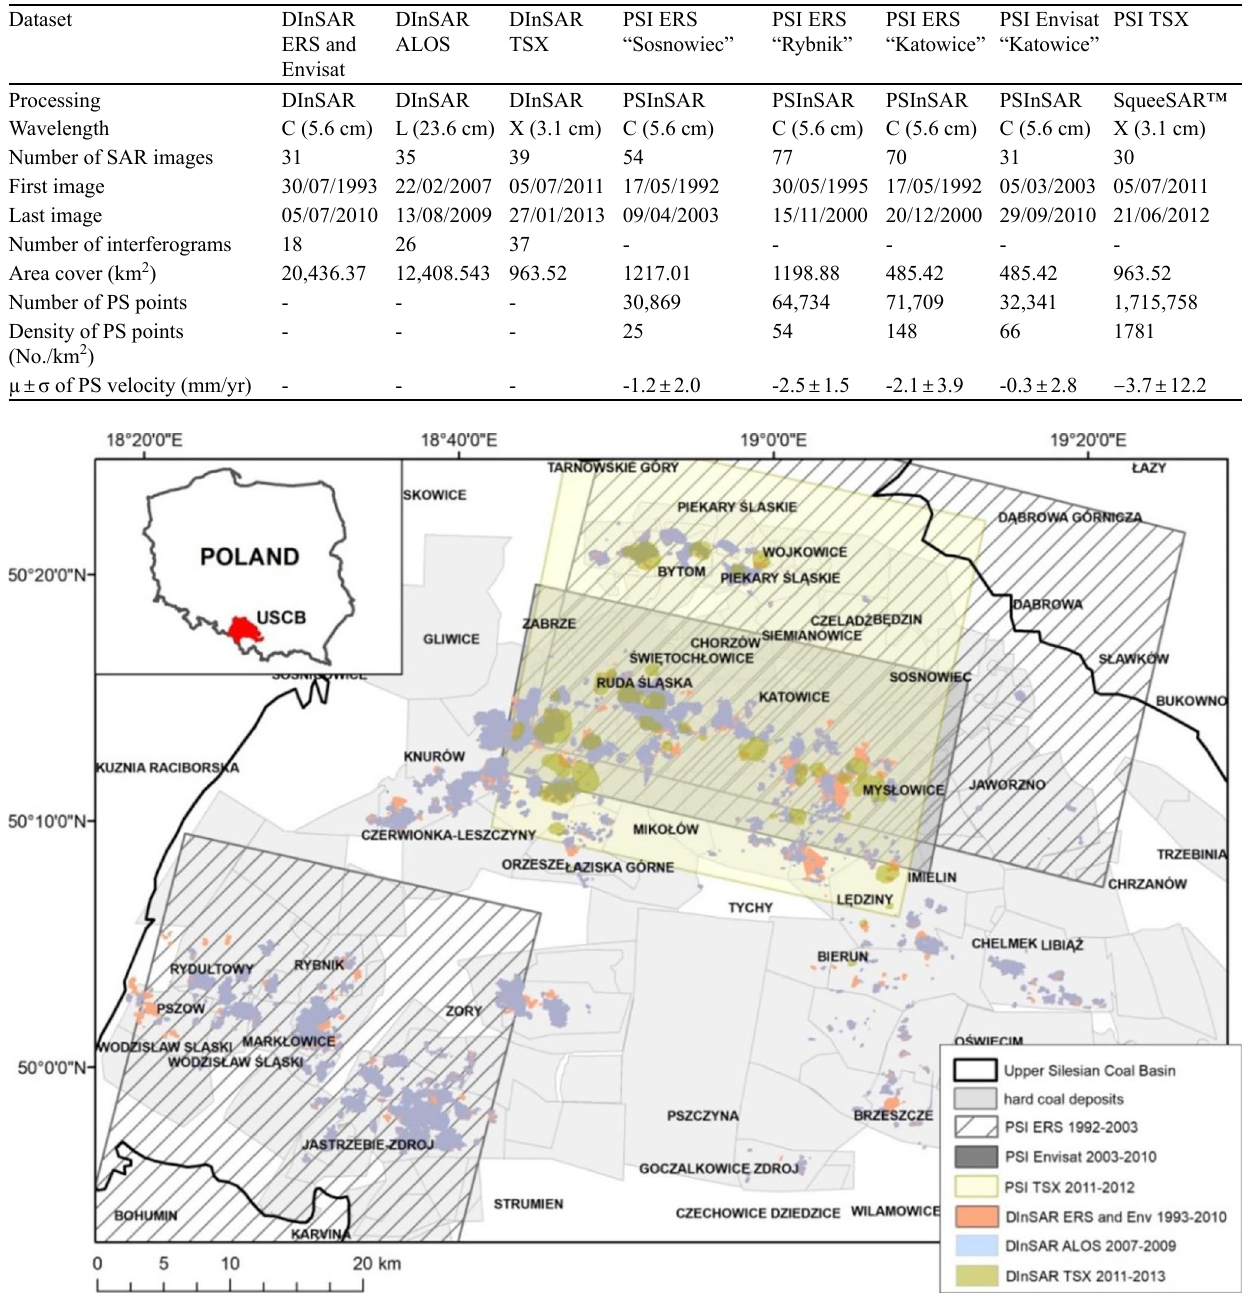
Fig. 1 Spatial coverage of InSAR datasets over Upper Silesian Coal